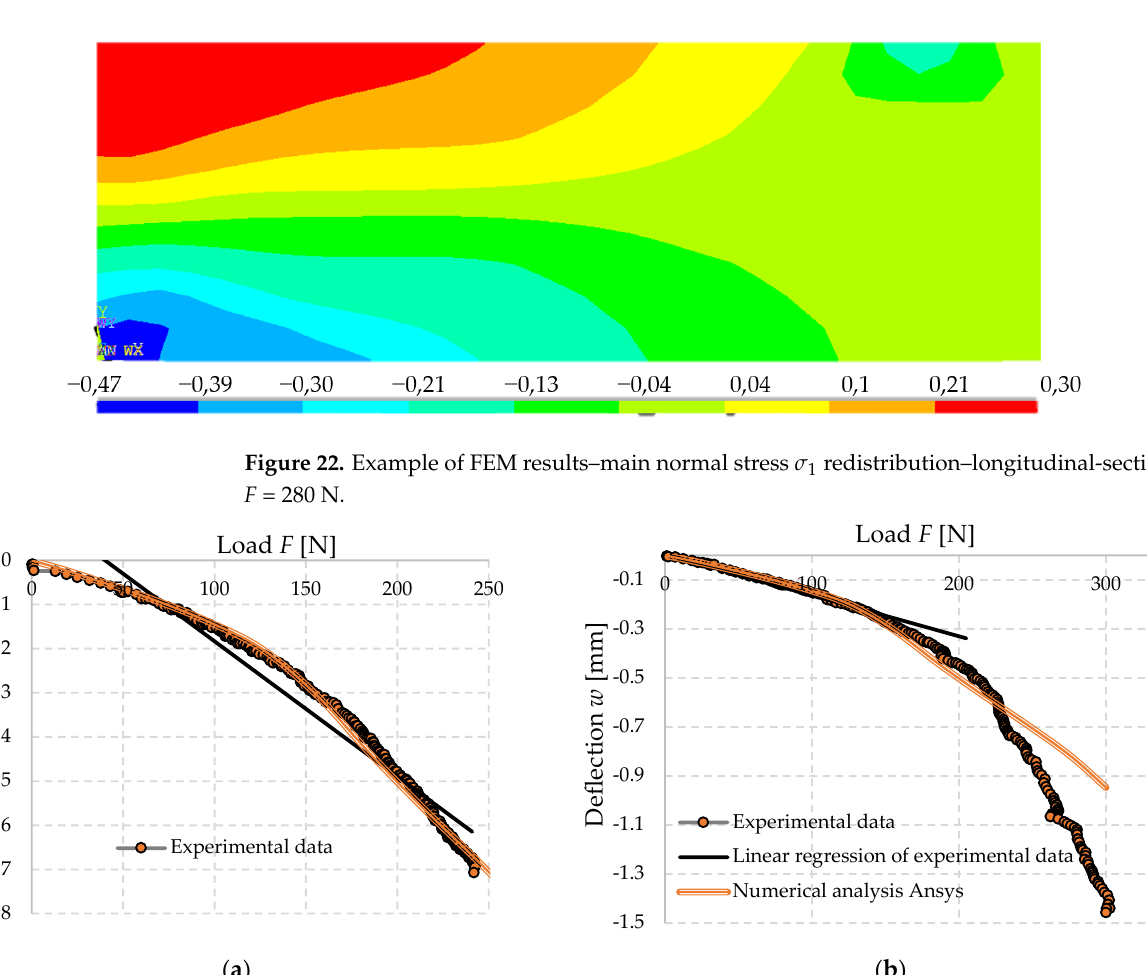
Figure 23. Comparison of numerical dependence of deflection (cantilever end) on force (load of the cantilever end) – investigated material FC500 ( a ) specimen 34030420 medium load capacity; ( b ) specimen 32030420 highest load capacity.